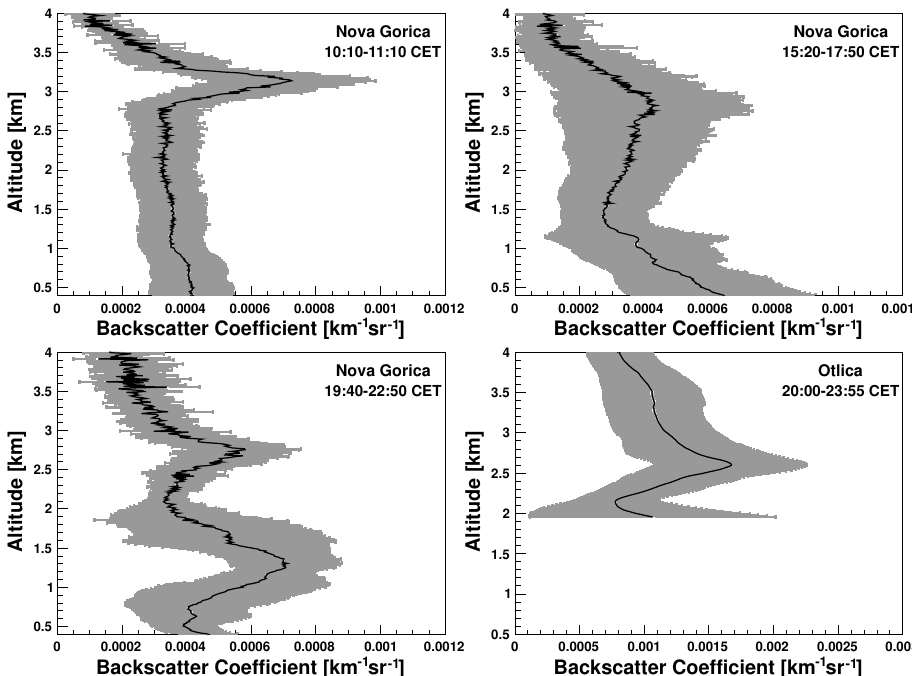
Fig. 5. Aerosol backscatter coefficients calculated by the Klett method during each time interval of the lidar measurements. The black line represents the mean value during each interval and the grey shaded areas the corresponding uncertainties of the measurement. Only the data within complete overlap is presented.